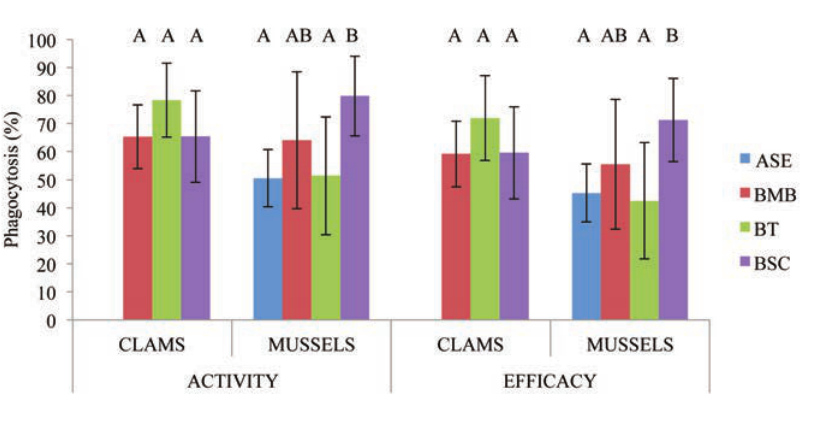
Figure 3. Phagocytic activity (1 bead and more) and efficacy (3 beads and more) of Mya arenaria (n=15) from three stations and Mytilus edulis (n=15) from four stations in the Saguenay River (ASE is excluded for clams because of the modulation induced by the salinity gradient, see Figure 1). Letters indicate significant difference between sites,